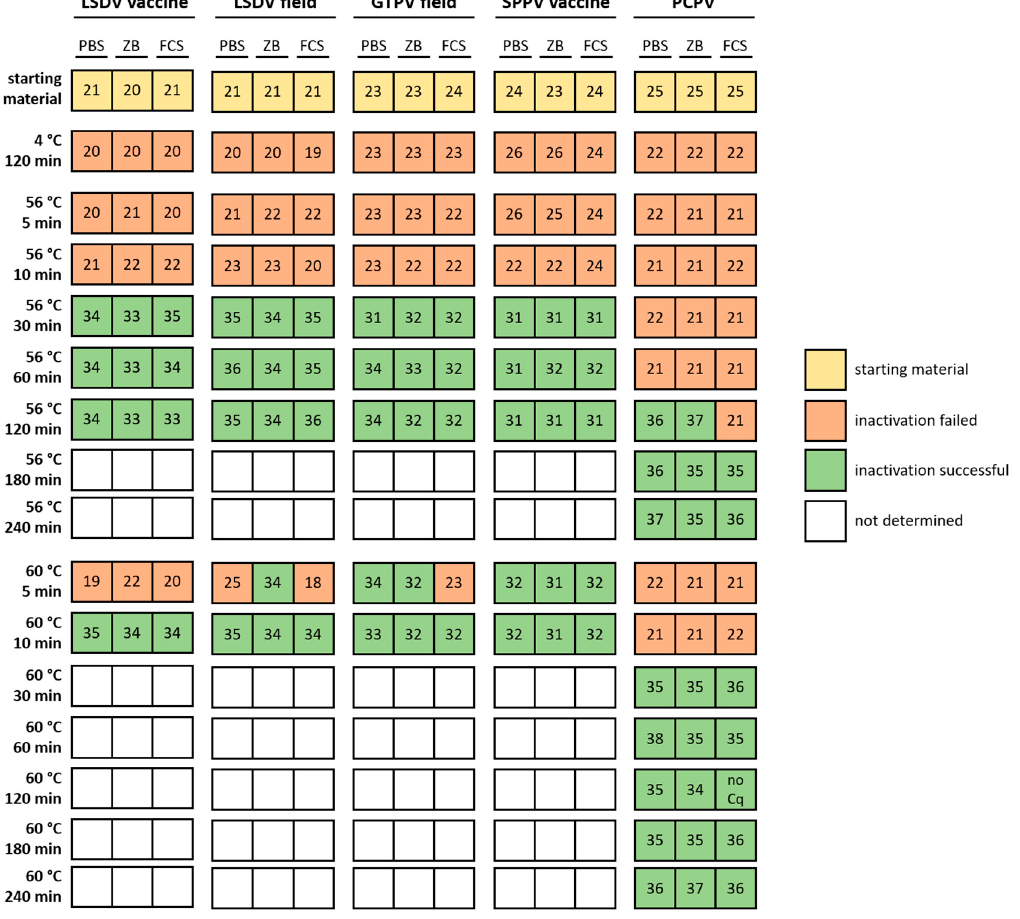
Figure 1. Thermal inactivation of different capripox virus strains as well as a pseudocowpox virus isolate. Four different capripox virus strains (LSDV vaccine strain “Neethling”, LSDV field strain “Macedonia2016”, GTPV field strain “V/103”, and SPPV vaccine strain “V/104”) and a single pseudocowpox virus isolate (PCPV) were diluted in different media (phosphate buffered saline pH 7.4 (PBS), cell culture medium with 10% FCS (ZB), and FCS only) and treated with different temperatures for different periods of time. Inactivation was validated or refused via analysis of the viral genome loads over three cell culture passages. Numbers indicate Cq-values. For the starting material, average Cq-value is given, and for thermal treatment, the Cq-value of the third cell culture passage is presented. Due to the reported analytical sensitivity of both assays of detecting less than 10 copy numbers/PCR reaction, a Cq of around 37 can be equated with approximately 10 copy no./PCR reaction. Therefore, a Cq of around 27 displays approximately 10,000 copy no./PCR reaction, a Cq of around 23 stands for approximately 100,000 copy no./PCR reaction, and a Cq of around 20 is related to approximately 1,000,000 copy no./PCR reaction.